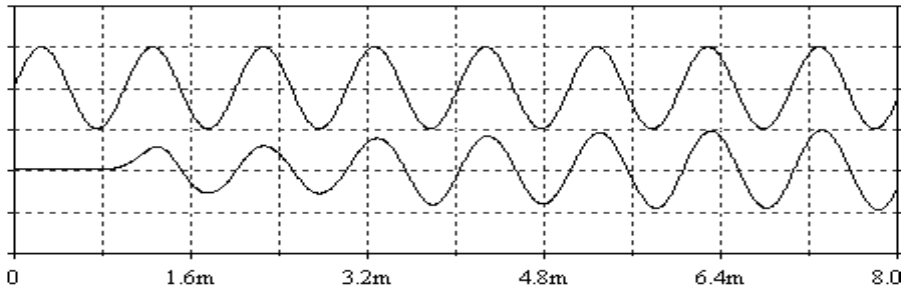
Figure 9. Time-delay waveform of sine signal (0.8 ms/div, 1 V/div).